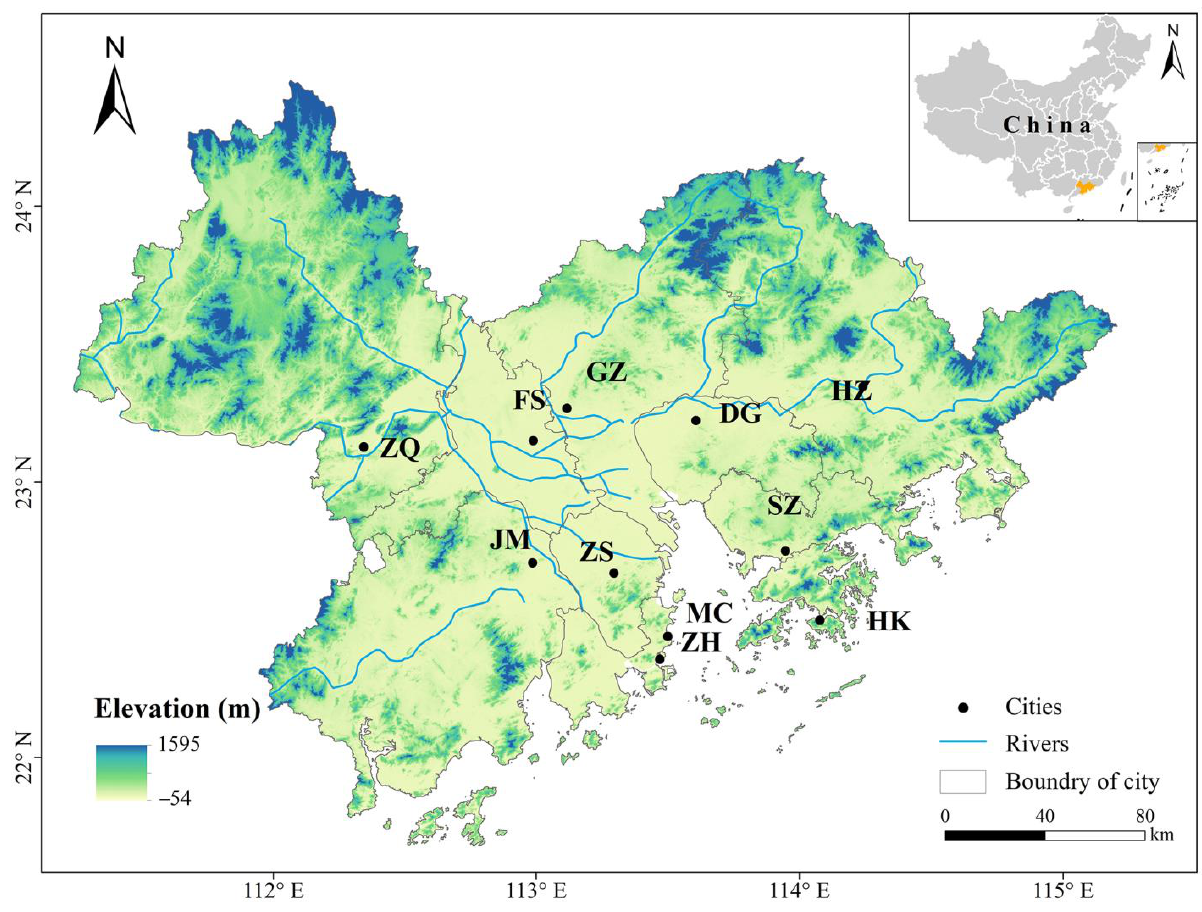
Figure 1. Location of the study area. DG: Dongguan; FS: Foshan; GZ: Guangzhou; HK: Hong Kong; HZ: Hhuizhou; MC: Macao; JM: Jiangmen; SZ: Shenzhen; ZH: Zhuhai; ZS: Zhongshan; ZQ: Zhaoqing.